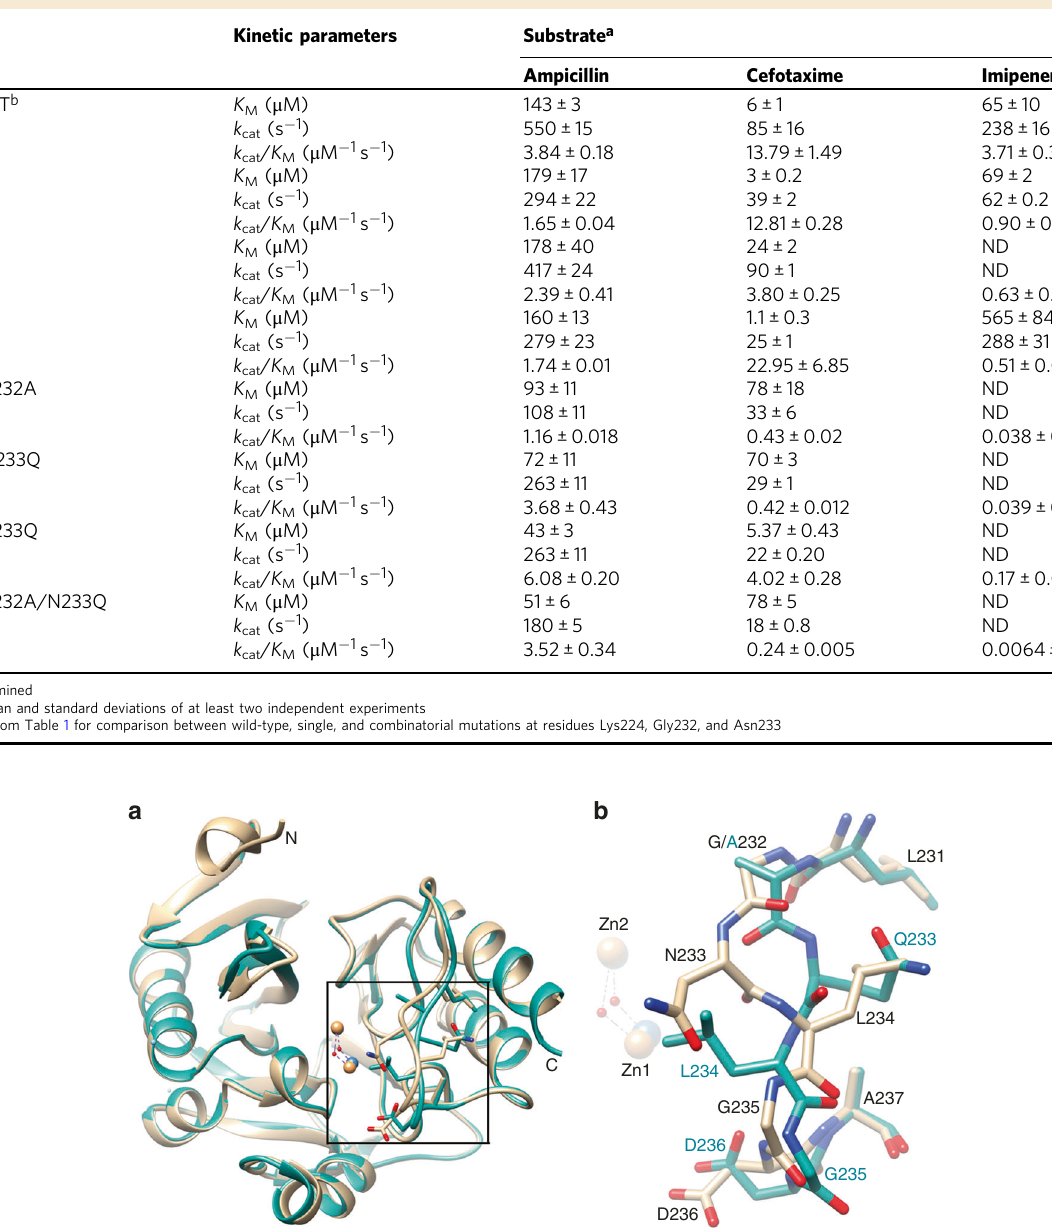
Fig. 6 Crystal structure of the NDM-1 K224R/G232A/N233Q mutant. a Left panel, alignment of structure of wild-type NDM-1 (tan, PDB ID: 3SPU 18 ) with that of NDM-1 K224R/G232A/N233Q (dark cyan). The zinc ions are represented as orange and gray spheres in the wild-type and mutant NDM-1 structures, respectively. The water molecule between Zn1 and Zn2 is shown as a red sphere. The side chains of residues 232 – 237 are shown within the boxed region of each structure. The box indicates the region of the structure shown in detail in panel B. The N- and C-termini are labeled. b Boxed region from panel ( a ) showing alignment of the structure of wild-type NDM-1 (tan, PDB ID: 3SPU) with that of NDM-1 K224R/G232A/N233Q (dark cyan) for residues 231 to 237. A large change in the conformation of the 231 – 237 region of the NDM-1 K224R/G232A/N233Q mutant is seen versus the structure of wild-type NDM-1